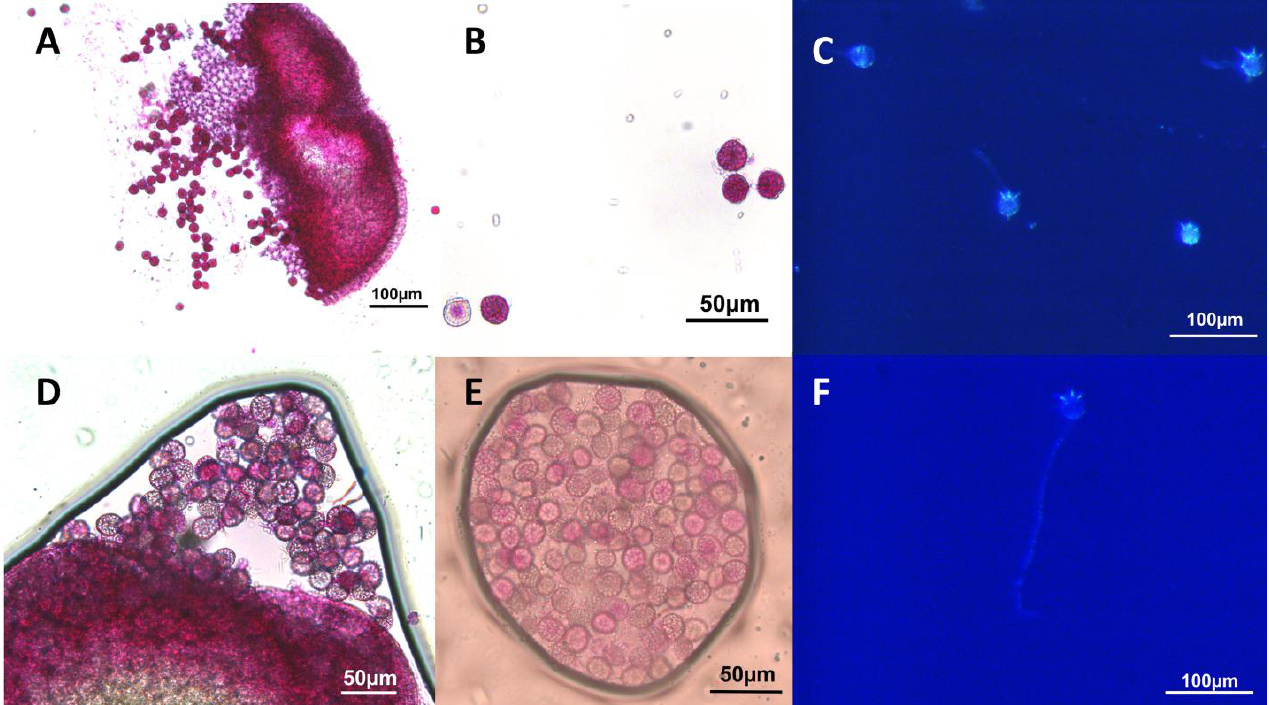
Figure 4. S. polyrhiza pollen analysis ( A , B ) Pollen from dehiscent anthers of strain 7498 stained with modified Alexander’s stain [52] indicating a high percentage of viability. Live pollen is pink or magenta, clear or blue stained pollen is aborted. ( C ) Pollen tube formation by pollen from dehisced anthers of strain 7498. ( D , E ) Alexander’s staining showed that anthers of strain 9509 produced viable pollen that was capable of forming pollen tubes ( F ).